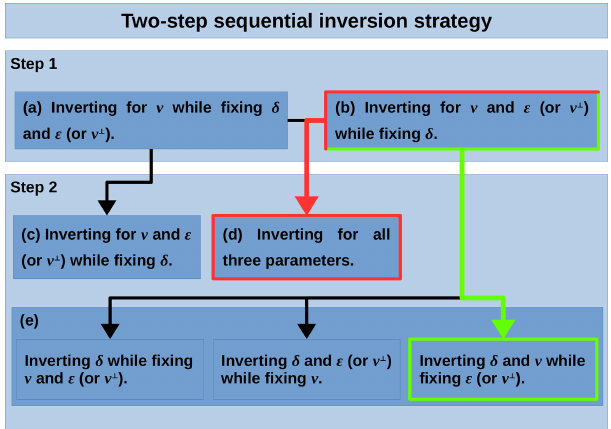
Figure 4. Flowchart describing the two steps for all the sequential inversion options tested. The best options for the sequential inver- sion strategy in P[ ε ] (Fig. 7) and in P[ v ⊥ ] (Fig. 8) are marked in green and red,